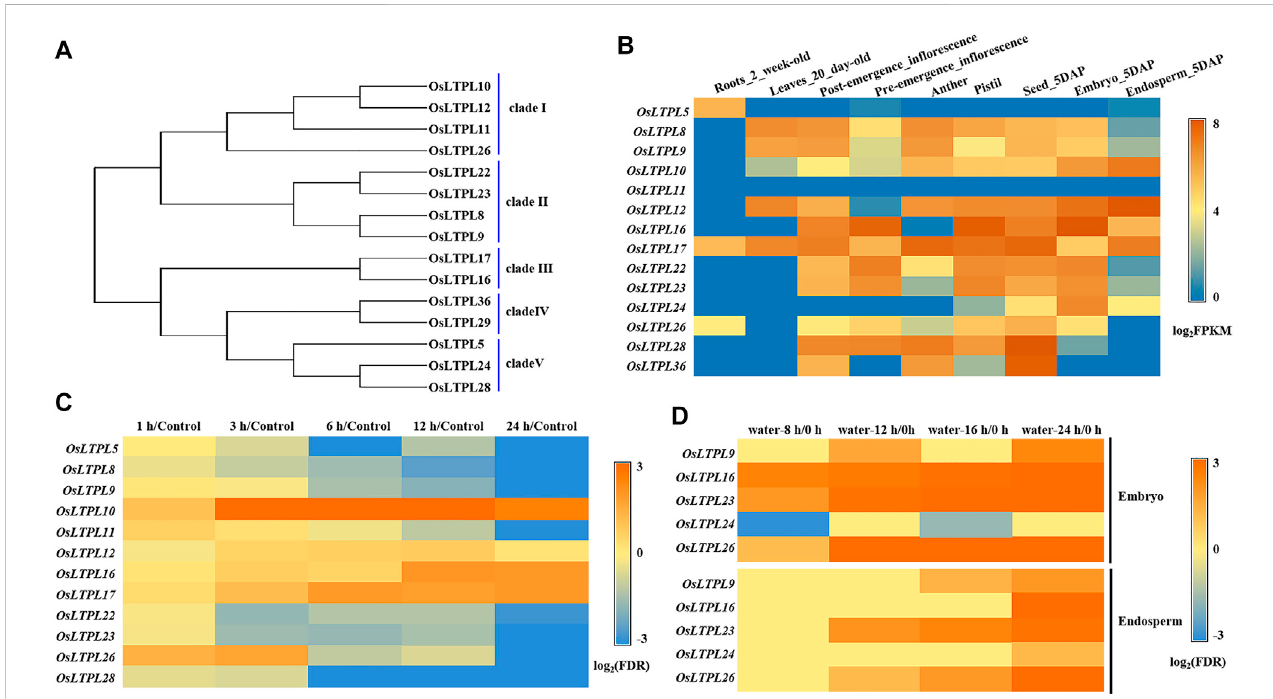
FIGURE 1 OsLTPL23 isspeci fi cexpressedinseeddevelopmentandgerminationprocessofrice. (A) PhylogenetictreeofthereportedricensLTPgenesexpressedin seed or embryo. (B) Tissue expression pro fi les of rice nsLTP genes from Plant Regulomics. (C) Transcription patterns of rice nsLTP genes response to ABA treatments. Blue and orange red boxes represent decreased and enriched transcript abundance, respectively. The gene expression level at 0 h after ABA treatment serves as control. (D) Transcription patterns of rice nsLTP genes in the imbibed embryo and endosperm under water treatment, respectively. Blue and orange red boxes represent down-regulated and up-regulated expression level,